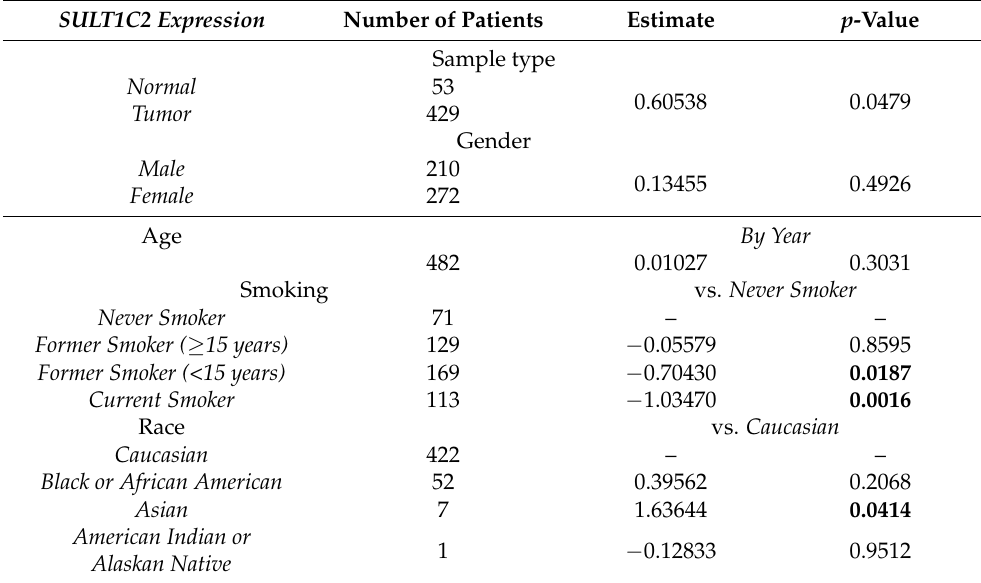
Table 2. SULT1C2 expression in TCGA LUAD. Multiple linear regression was used to include all listed clinical features into one model. Bolded p values were considered